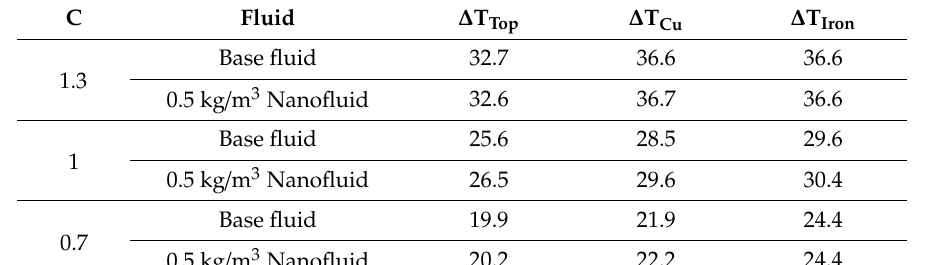
Table 4. Mean experimental gradients of temperature (K) for each fluid, load index C and probe.